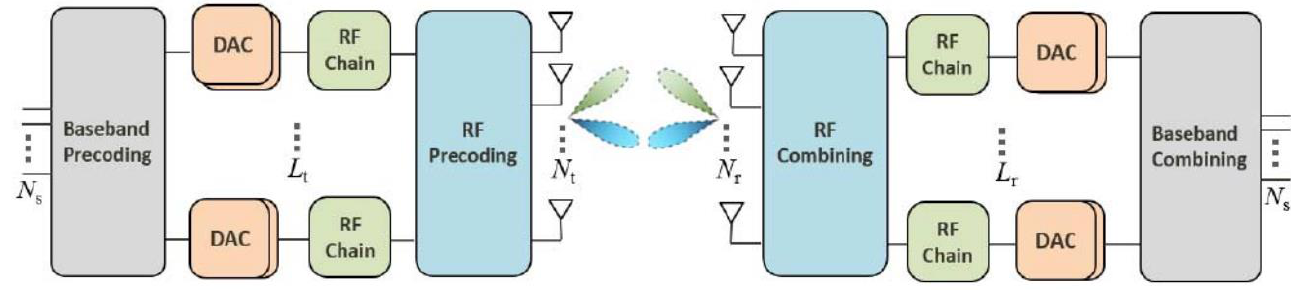
Figure 4. Hybrid beamforming [29].